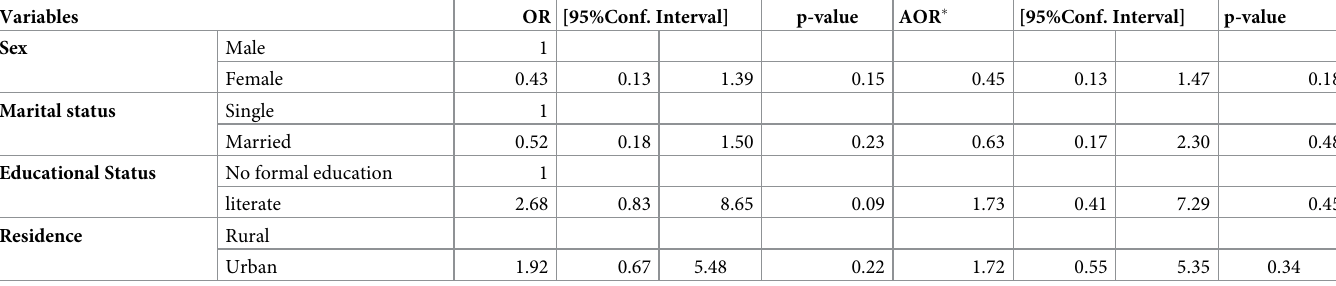
Table 2. Association between dependent and predictor variables among study participants in leprosy endemic setting, Fedis District, 2019(n = 262).